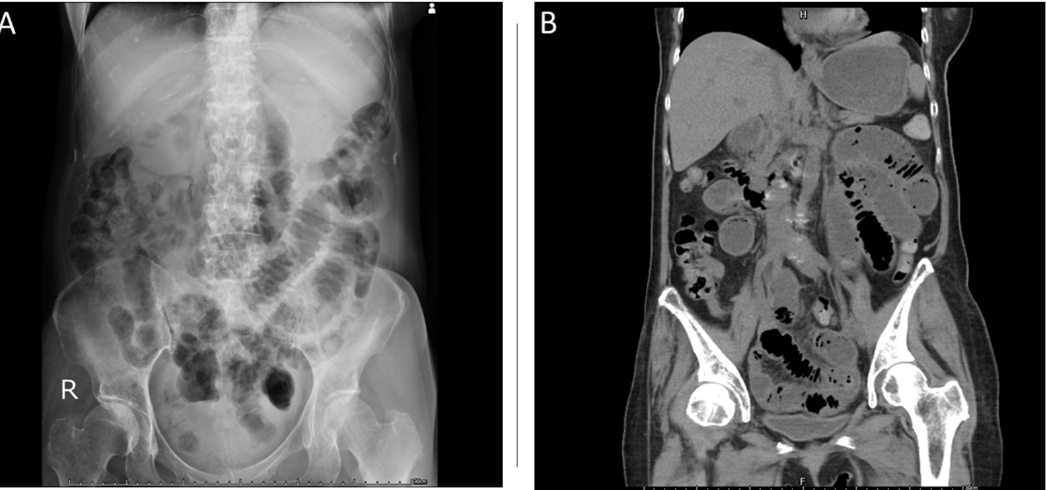
Figure 1. Abdominal plain view computed tomography (CT). ( A ) Abdominal plain view CT showing distention of small bowel loops with a coiled spring sign. ( B ) Abdominal CT showing generally dilated, air-fluid levels in the intestine, compatible with small intestinal obstruction.